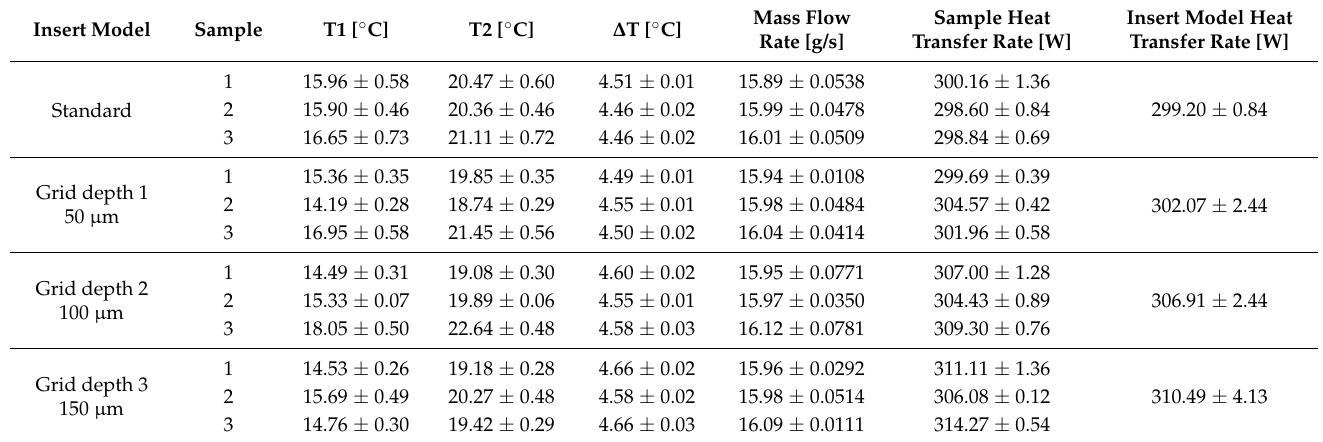
Table 4. Experimental thermal results for different insert